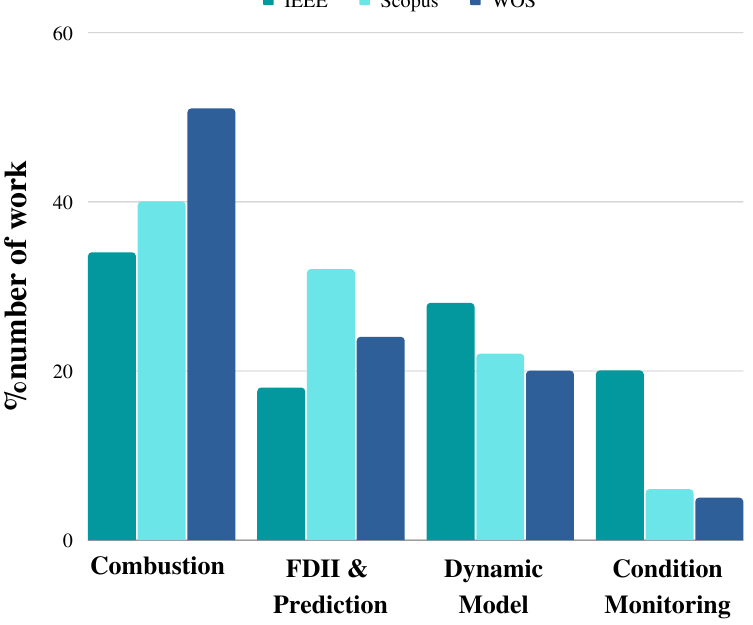
Figure 3. Various fields of work published in Scopus, WOS, and IEEE Database. This paper aims to provide an overview of the DLE gas turbine as one of the top clean gas turbine technology. The flow of paper organization is represented by Figure